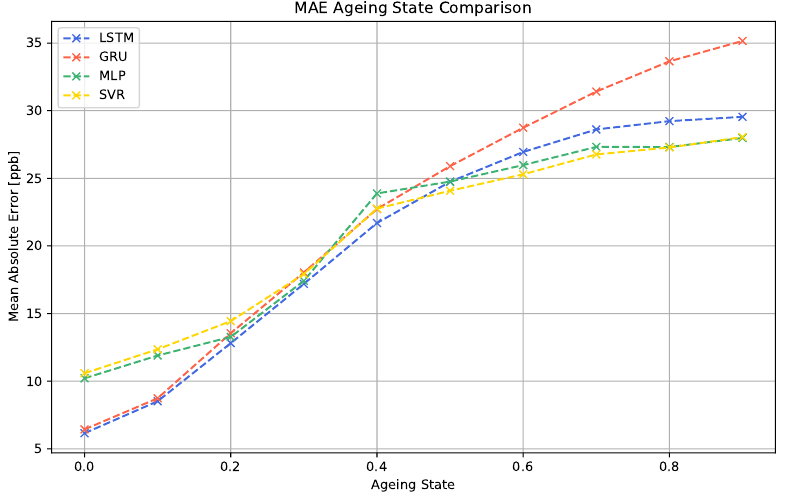
Figure 13. Comparison of the MAE across the different regression models for different ageing states.